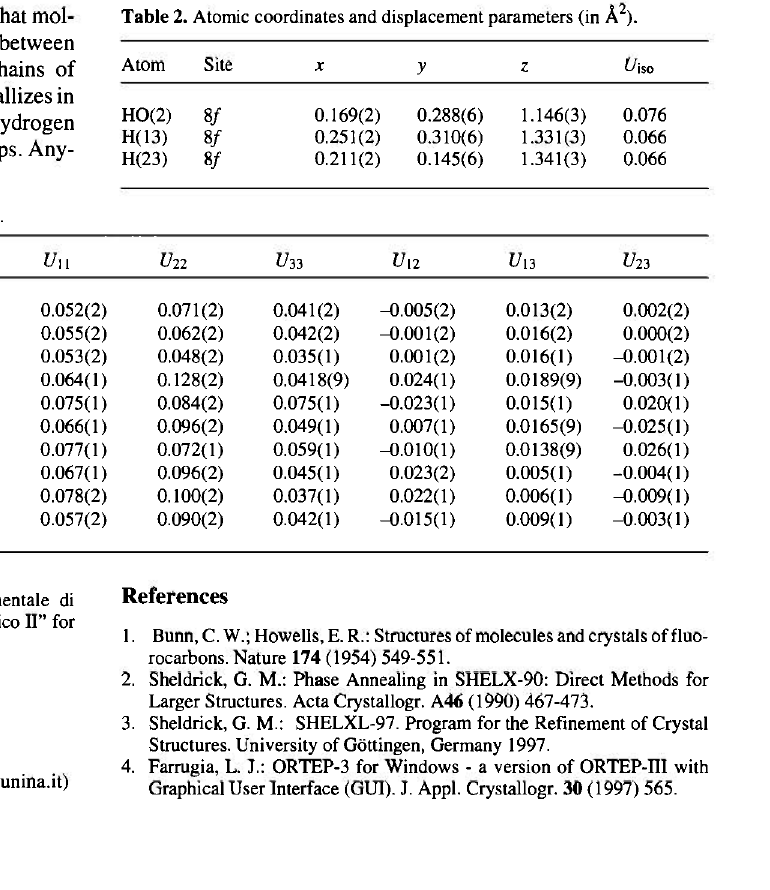
Table 2. Atomic coordinates and displacement parameters (in Ä 2